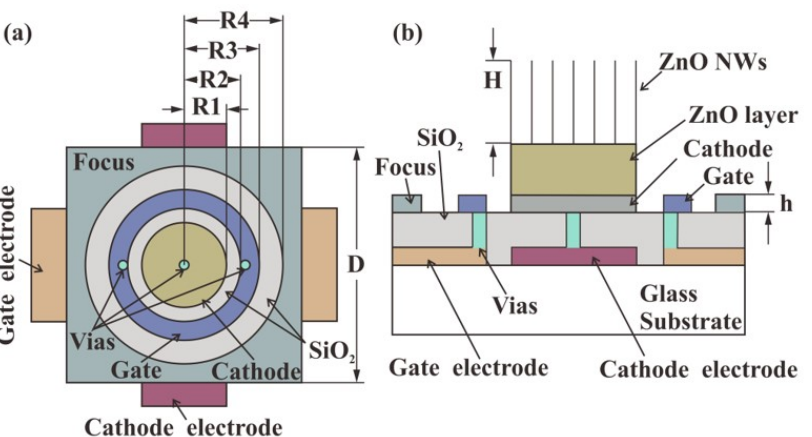
Figure 1. Schematic of the coaxis planar-gated ZnO nanowire FEAs with an in-plane focusing gate electrode. ( a ) Top view of one pixel; ( b ) cross-sectional view of one